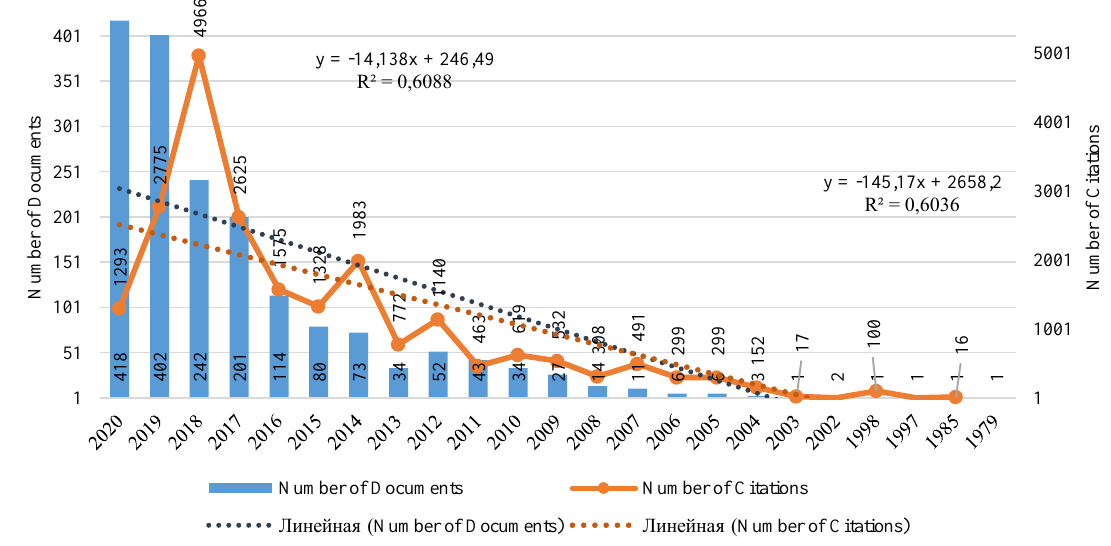
Figure 1. Dynamics of Publications and Citations for the Search Query “Open Science” in Scopus Source: Compiled by the authors using Scopus data (Scopus,